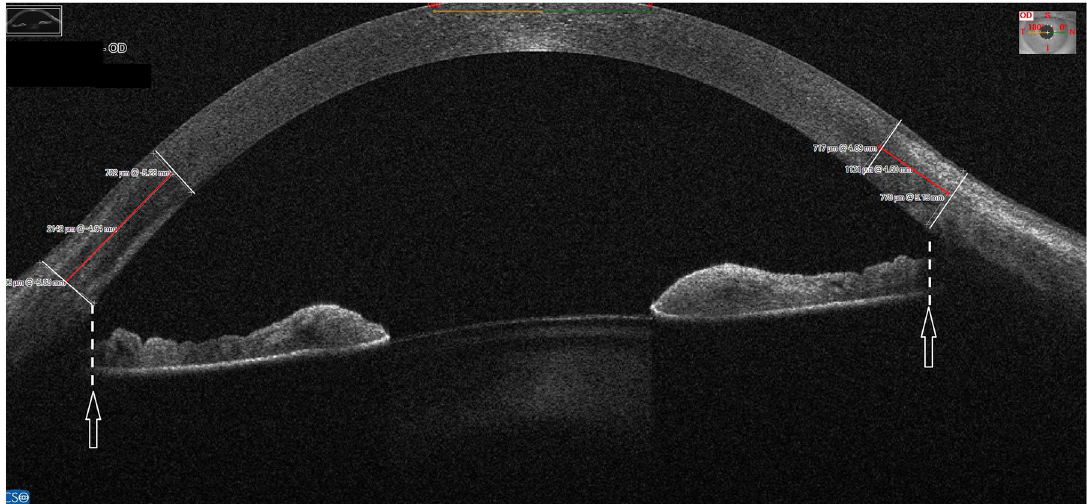
Fig 1. The assessment of corneo-scleral junction width. The horizontal AS-OCT scan of the right eye with callipers set to measure the corneo-scleral junction width (red lines) as a distance between last optically clear corneal section and first optically opaque scleral section. Determination of posterior limbal border was supported with the optical shadowing of iris from the scleral tissue (white arrows). Dashed lines perpendicular to the iris, with a starting point at the last visible iris pigment epithelium, point at the first fully opaque scleral section.